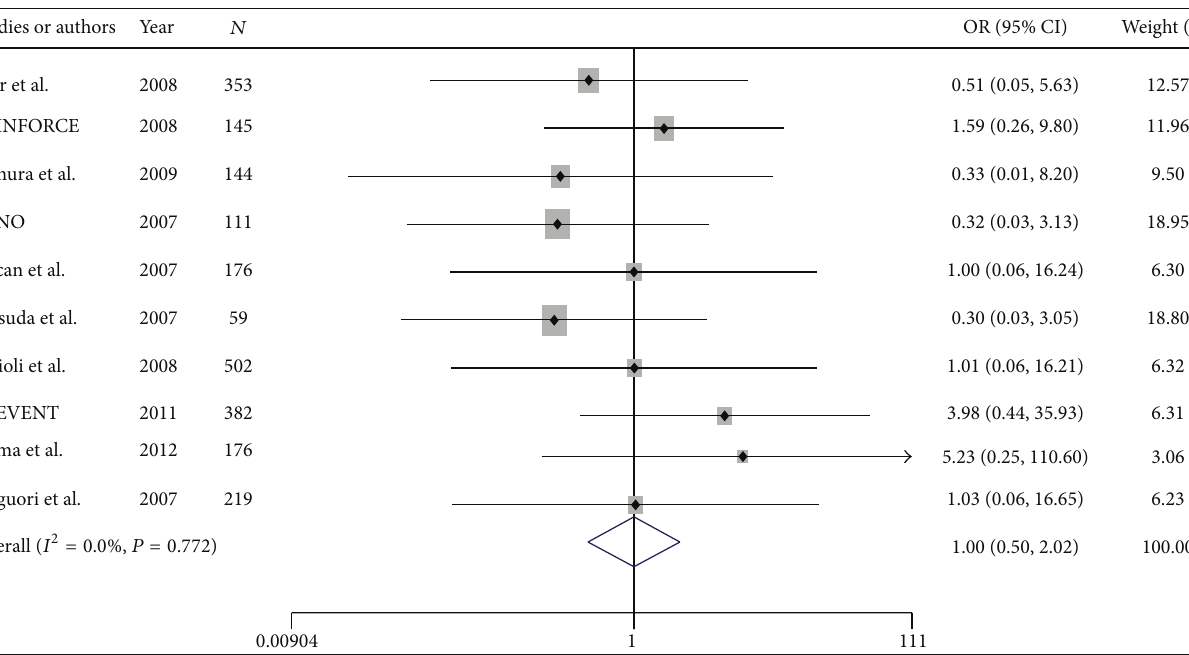
Figure 2: Forest plot of odds ratio (OR) for hydration with sodium bicarbonate on incidence of requirement dialysis.